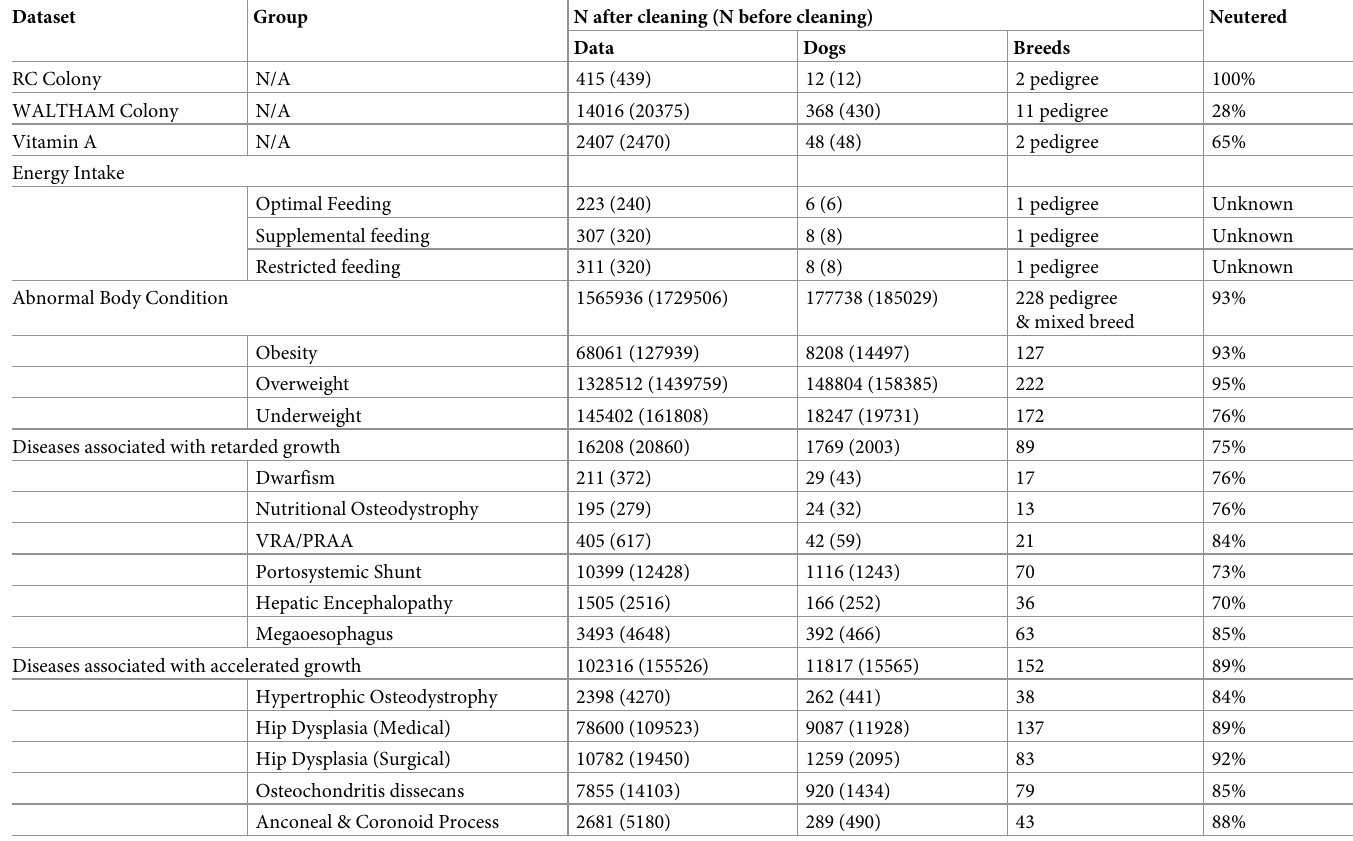
Table 1. Details of validation